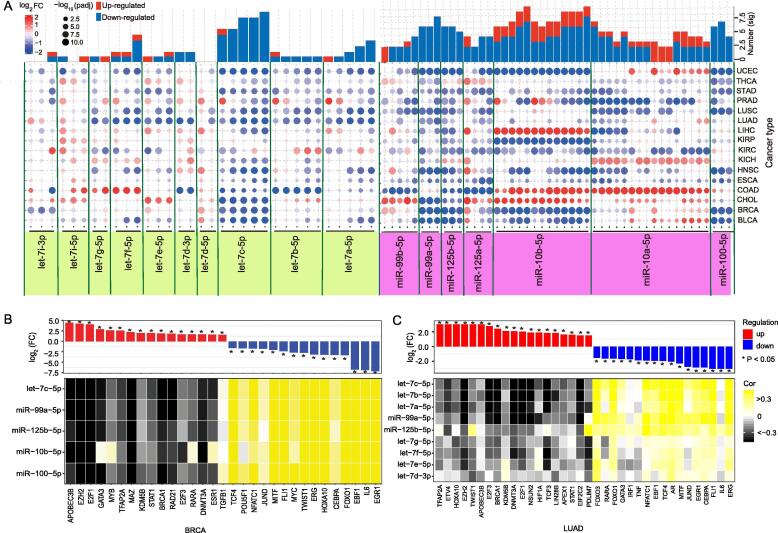
IsomiR repertoires of the let-7 gene family and related family miR-10 in 16 cancers. (A) Expression patterns of selected abnormal isomiRs from the two gene families across 16 cancer types (isomiRs with an RPM value not less than 50 and a baseMean value not less than 500 in at least one cancer type were selected). The log2FC distribution was estimated based on the original log2FC values. The numbers of deregulated isomiRs are also presented (number (sig.)). (B) Correlations among related transcription factors (TF) and miRNAs from the two gene families in BRCA patients (n = 1,207). (C) Correlations among related transcription factors (TF) and miRNA from the two gene families in LUAD patients (n =567).